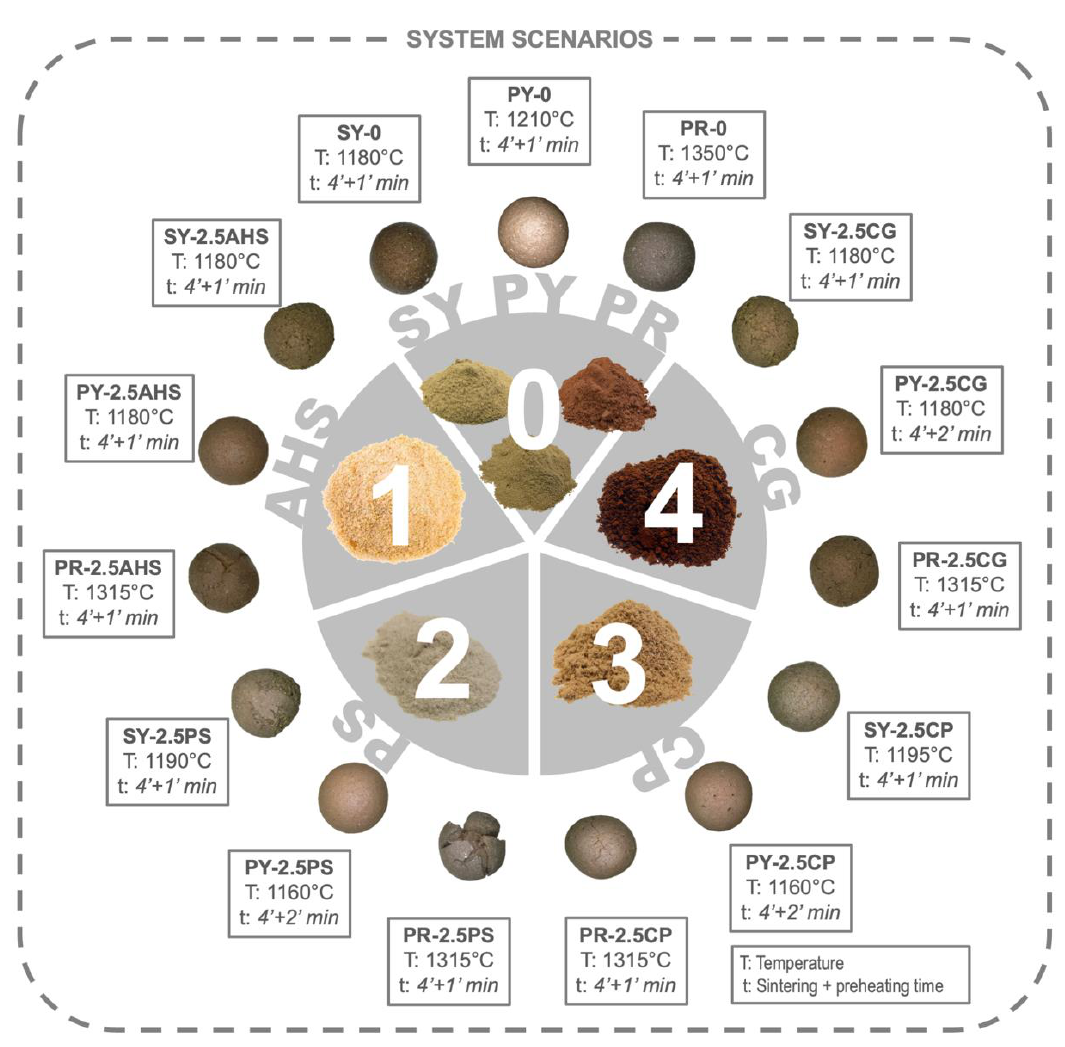
Figure 2. System scenarios considered: ( 0 ) LWA from SY, PY and PR without residues; ( 1 ) LWA from SY, PY and PR with 2.5 wt % almond and hazelnut shells (AHS); ( 2 ) LWA from SY, PY and PR with 2.5 wt % paper sewage sludge (PS); ( 3 ) LWA from SY, PY and PR with 2.5 wt % cork dust (CP); ( 4 ) LWA from SY, PY and PR with coffee grounds (CG).